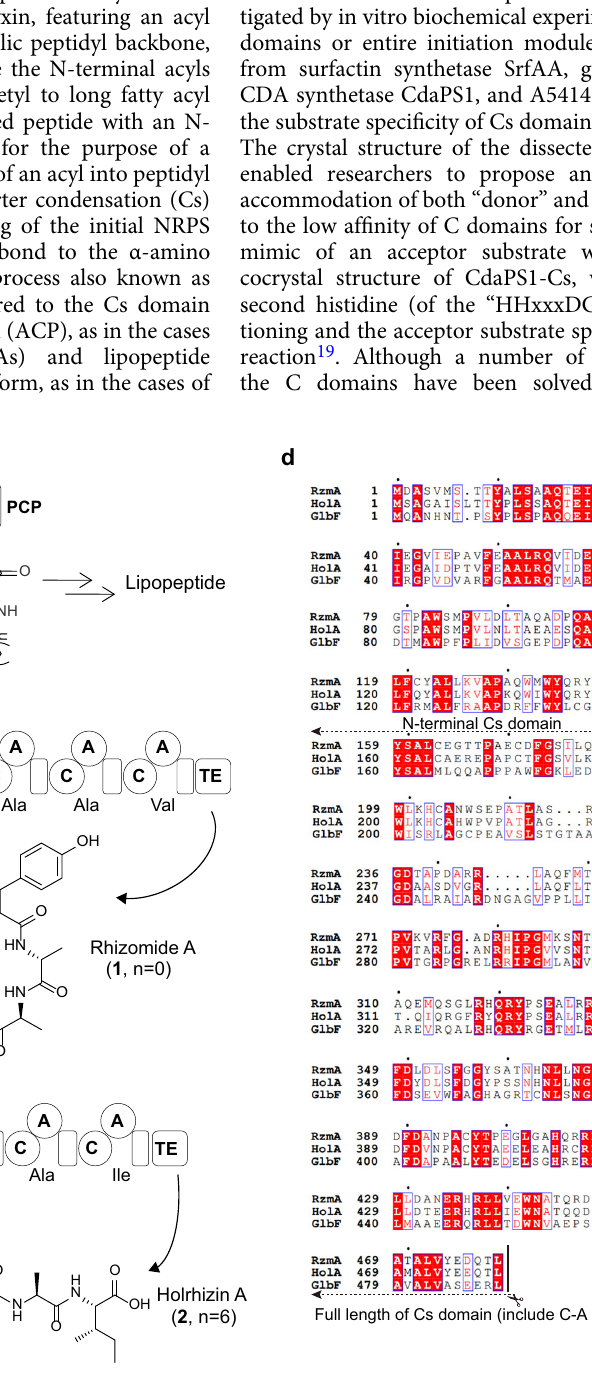
Fig. 1 Biosynthesis of nonribosomal lipopeptides. a The starter condensation (Cs) domain catalyzes the lipoinitiation of lipopeptide biosynthesis using acyl-ACP or acyl-CoA as a substrate. b , c The rhizomide and holrhizin biosynthetic pathways (RzmA and HolA) from P. rhizoxinica , and their main products rhizomide A ( 1 ) and holrhizin A ( 2 ), which bear a short acetyl and a medium octanoyl moieties, respectively. d Sequence alignment of RzmA-Cs, HolA-Cs, and GlbF-Cs. The swapping sites of the full-length Cs domain and subdomain (N-lobe) are labeled with a black line and a pair of scissors, respectively. A adenylation domain, ACP acyl carrier protein, C condensation domain, PCP peptidyl carrier protein, TE thioesterase